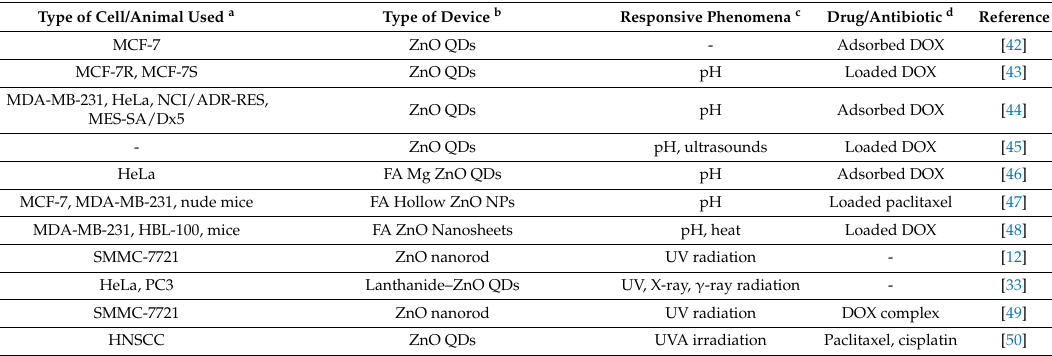
Table 1. ZnO nanoplatforms for theranostic in Cancer.